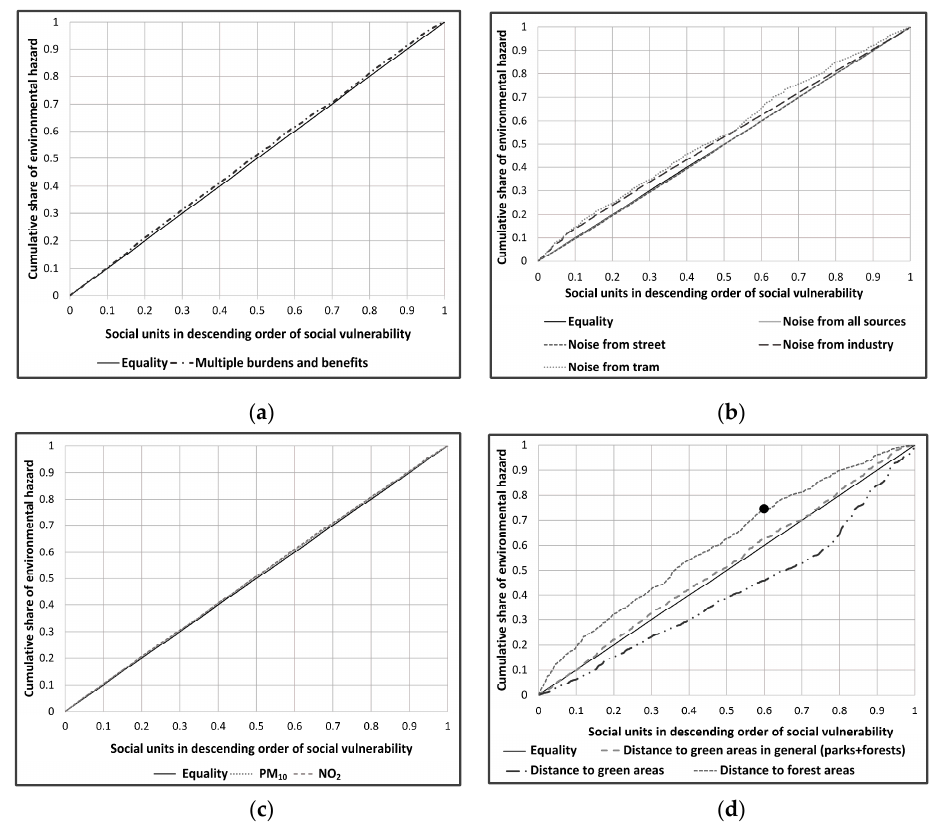
Figure 2. ( a ) Concentration curves illustrating the distribution of indicators for combination of factors with regard to social units having varying social vulnerability; ( b ) Concentration curves illustrating the distribution of noise indicators from individual sources and combined noise exposure (logarithmic addition of noise level from all sources) with regard to social units having varying social vulnerability; ( c ) Concentration curves illustrating the distribution of air pollution indicators with regard to social units having varying social vulnerability; ( d ) Concentration curves illustrating the distribution of green areas (public parks, cemeteries) and forests separately and green areas in general (parks, cemeteries, forests) with regard to social units having varying social vulnerability. For example the point in ( d ) illustrates that when the cumulative share of social units is 60%, those social units with higher social vulnerability bear the disproportionate share of distance to forest areas of 75%.